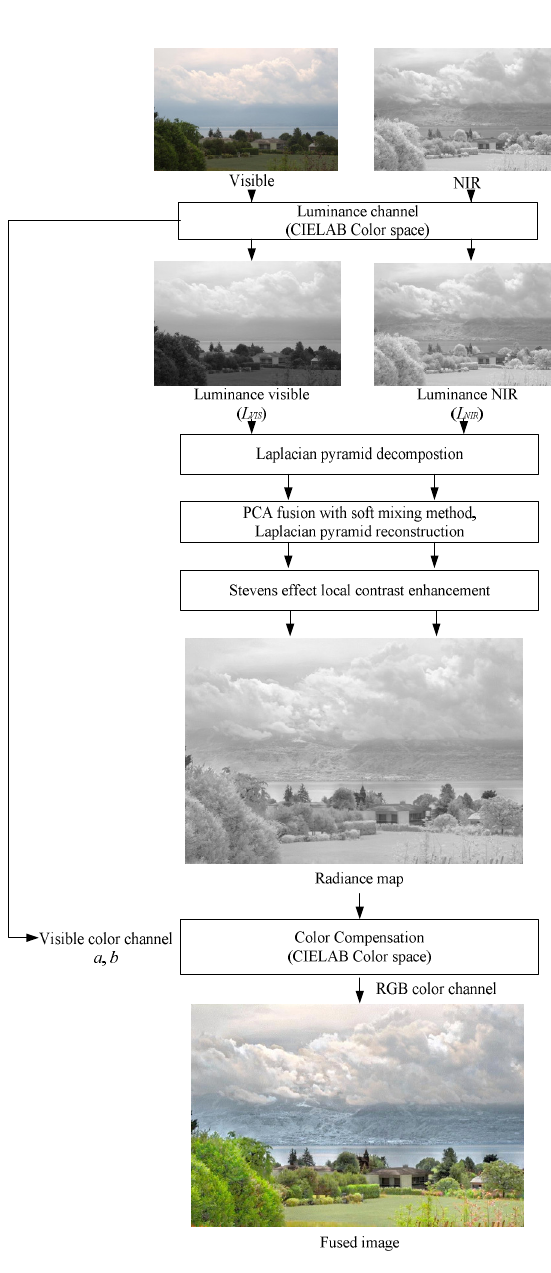
Figure 3. Flowchart of the proposed algorithm.